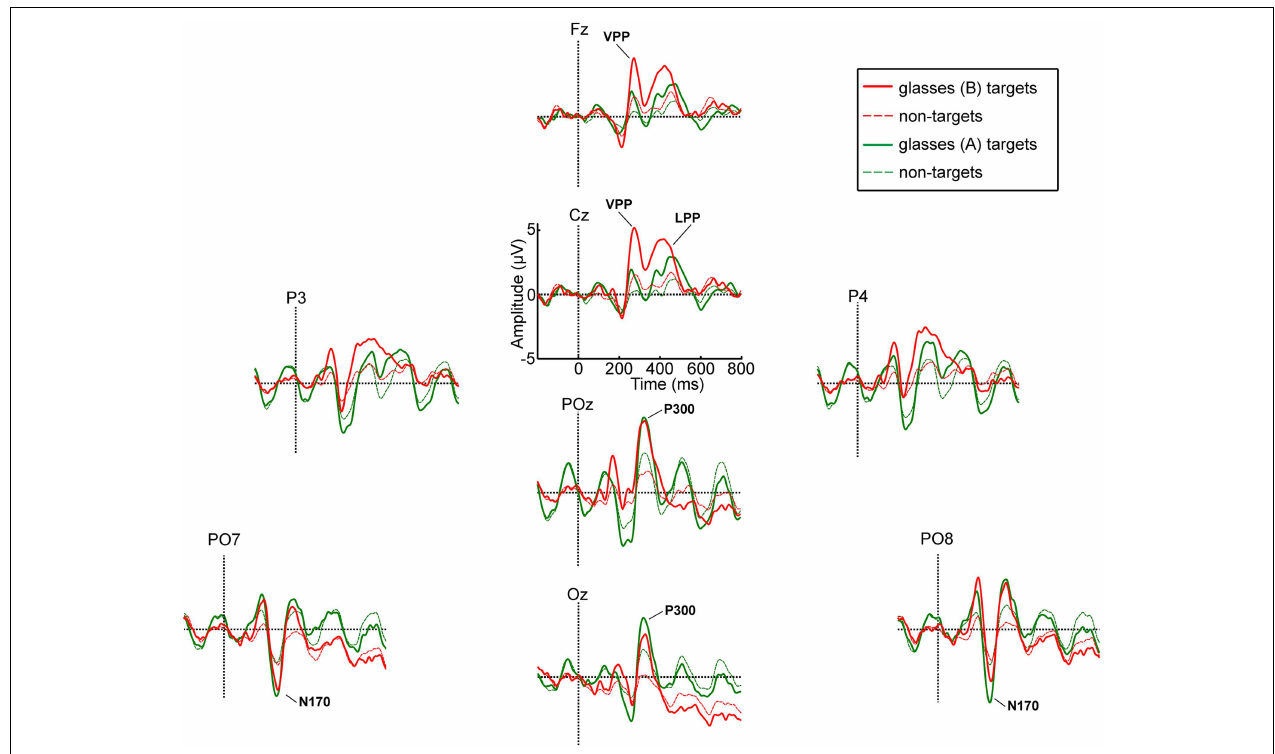
FIGURE 6 | Grand average ERP waveforms for targets and non-targets for the glasses A and glasses B condition.